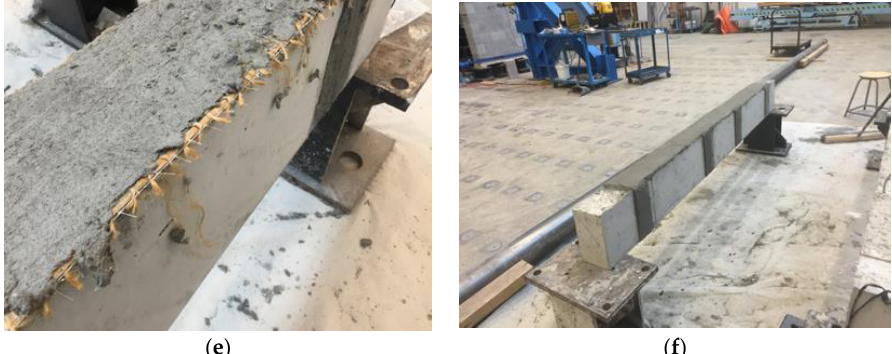
Figure 7. Strengthening procedure: ( a ) initial mortar layer applied; ( b ) FRCM mesh partially embedded inside the mortar; ( c ) FRCM mesh embedded totally inside the mortar; ( d ) U-wrapped FRCM strips embedded inside the mortar; ( e ) FRCM mesh covered with mortar; ( f ) finishing after the application of the second FRCM layer.